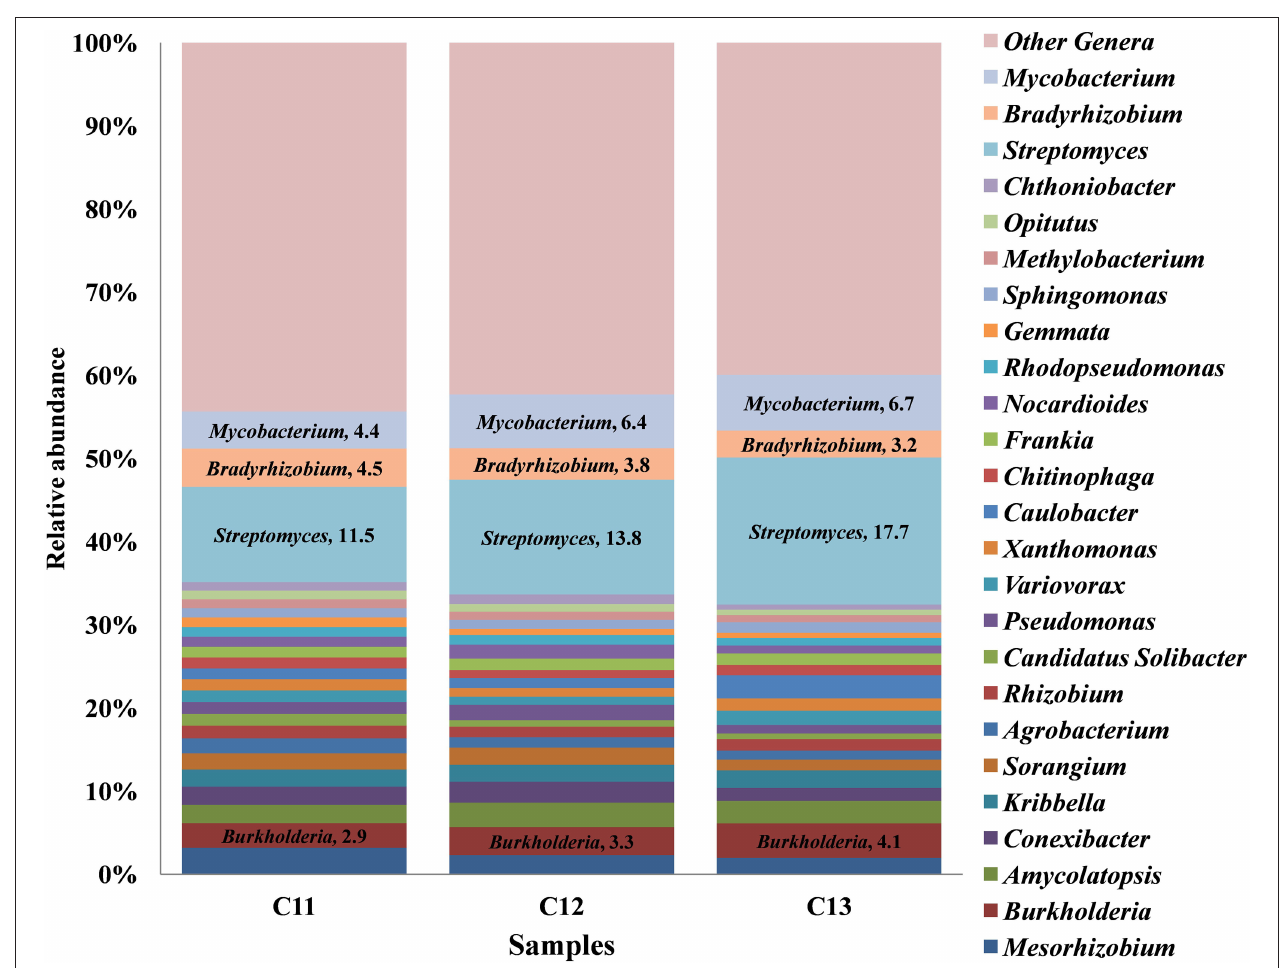
FIGURE 3 | Relative abundance of top 25 genera cataloged from Kishtwar cormosphere in the three consecutive years (2011, 2012, and 2013). The bar graph represents 42 genera common in all the three Kishtwar samples out of 52 genera cataloged in this study.